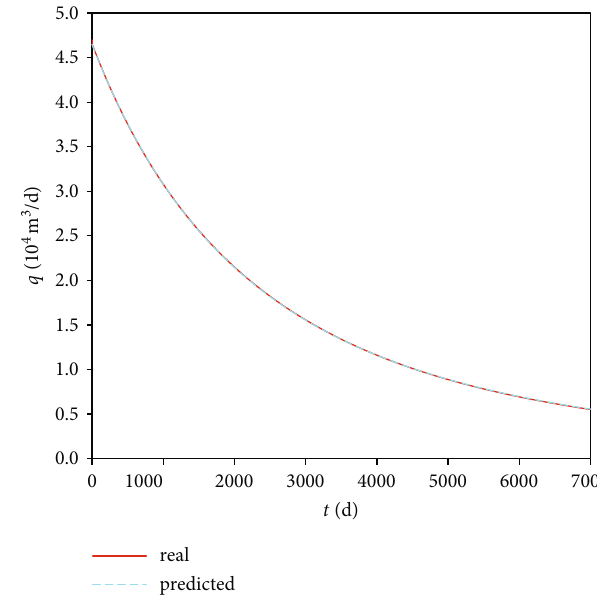
Figure 13: The real q pro fi le and the predicted pro fi le by the hyperbolic decline model for Case